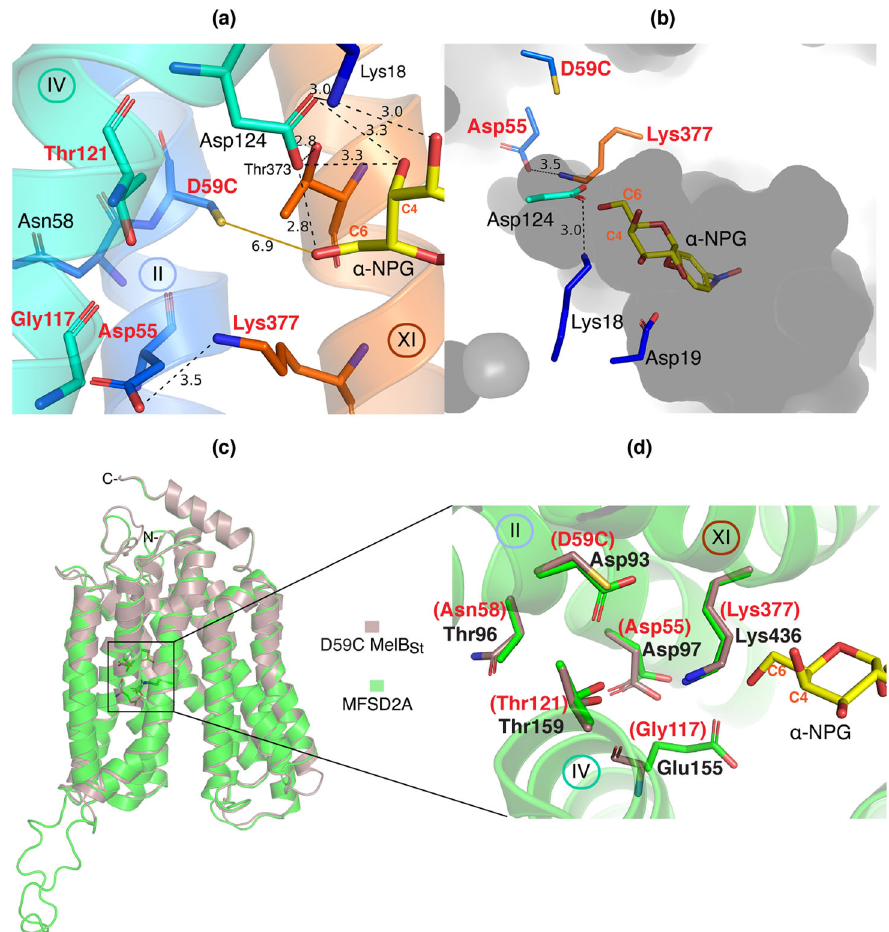
Fig. 5 Proposed cation-binding pocket [PDB ID, 7L17]. H-bond and salt-bridge interactions are indicated by black dashed lines with distance shown in Å. a Potential cation-binding site. Positions that have been determined to be involved in MelB cation binding including Asp55, Asp59, Gly117, Thr121, and Lys377 are labeled in red. Asp55 forms a salt-bridge with Lys377 at a distance of 3.5 Å. The C6-OH on the speci fi c galactosyl ring is at a 6.9 Å distance to the sulfur atom on D59C, as indicated by the yellow line. Helices IV and XI carrying Tyr120, Asp124, Thr373, and Lys377 link the sugar speci fi city determinant pocket to the cation pocket. b A cross-section of surface representation of cation- and sugar- speci fi c pockets. Internal solvent accessible cavity is shown in gray. Important charged residues (4 Asp and 2 Lys) and α -NPG molecule are shown in sticks. D59C is in a less solvent-accessible position than all other sidechains. c A 3-D model of the human MFSD2A. SWISS-MODEL server was used to model the outward-facing 3-D structure of the human MFSD2A (in green) using MelB D59C structure 7L17 as template (in dirty violet). d Potential cation site of the human MFSD2A overlaid with D59C MelB St mutant. The proposed cation site from the threading model in panel c was zoomed in to show the side chains (labeled in black text), which are conserved with the proposed cation site in MelB (labeled in red